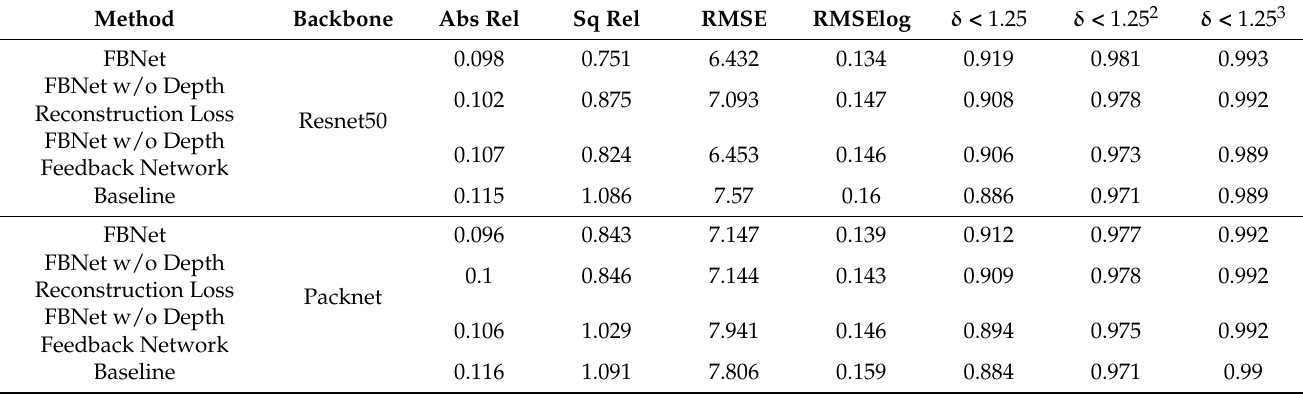
Table 2. Ablation study on the FBNet. We perform the ablation study under the same conditions as the comparative experiment. Performance is shown when depth reconstruction loss and depth feedback network are removed from the proposed full